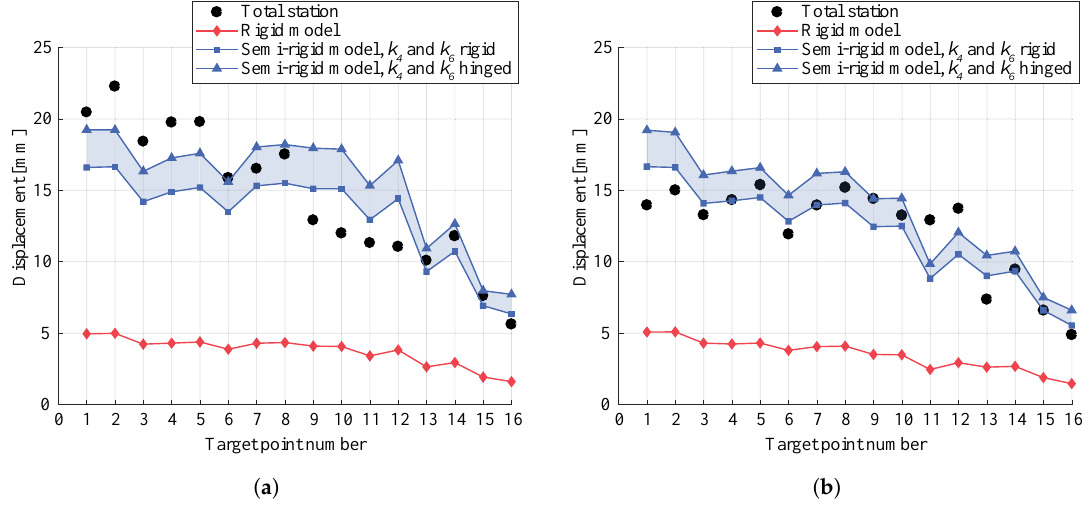
Figure 13. Comparison between the displacements measured with the total station and results predicted by a rigid model and semi-rigid models with k 4 and k 6 either rigid or hinged for: ( a ) test n° 1; ( b ) test n° 2. Target point numbers correspond to the 16 target points indicated in Figure